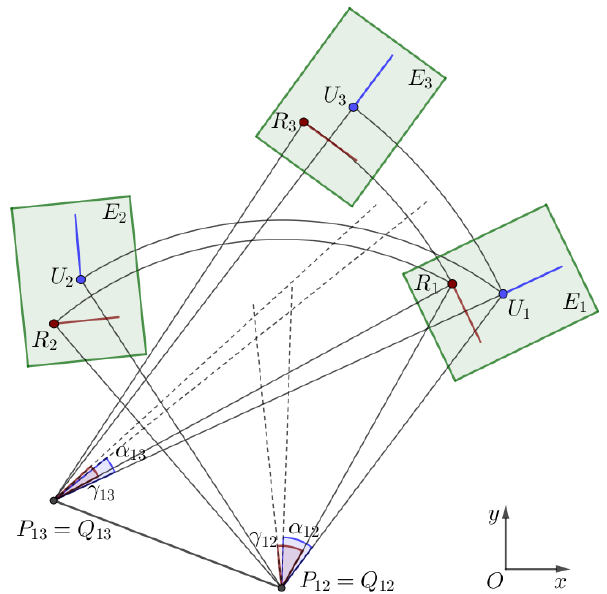
Figure 2. Position description by the pole map.